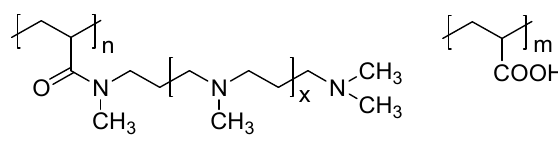
Figure 2. Structure of the synthesized polymers.